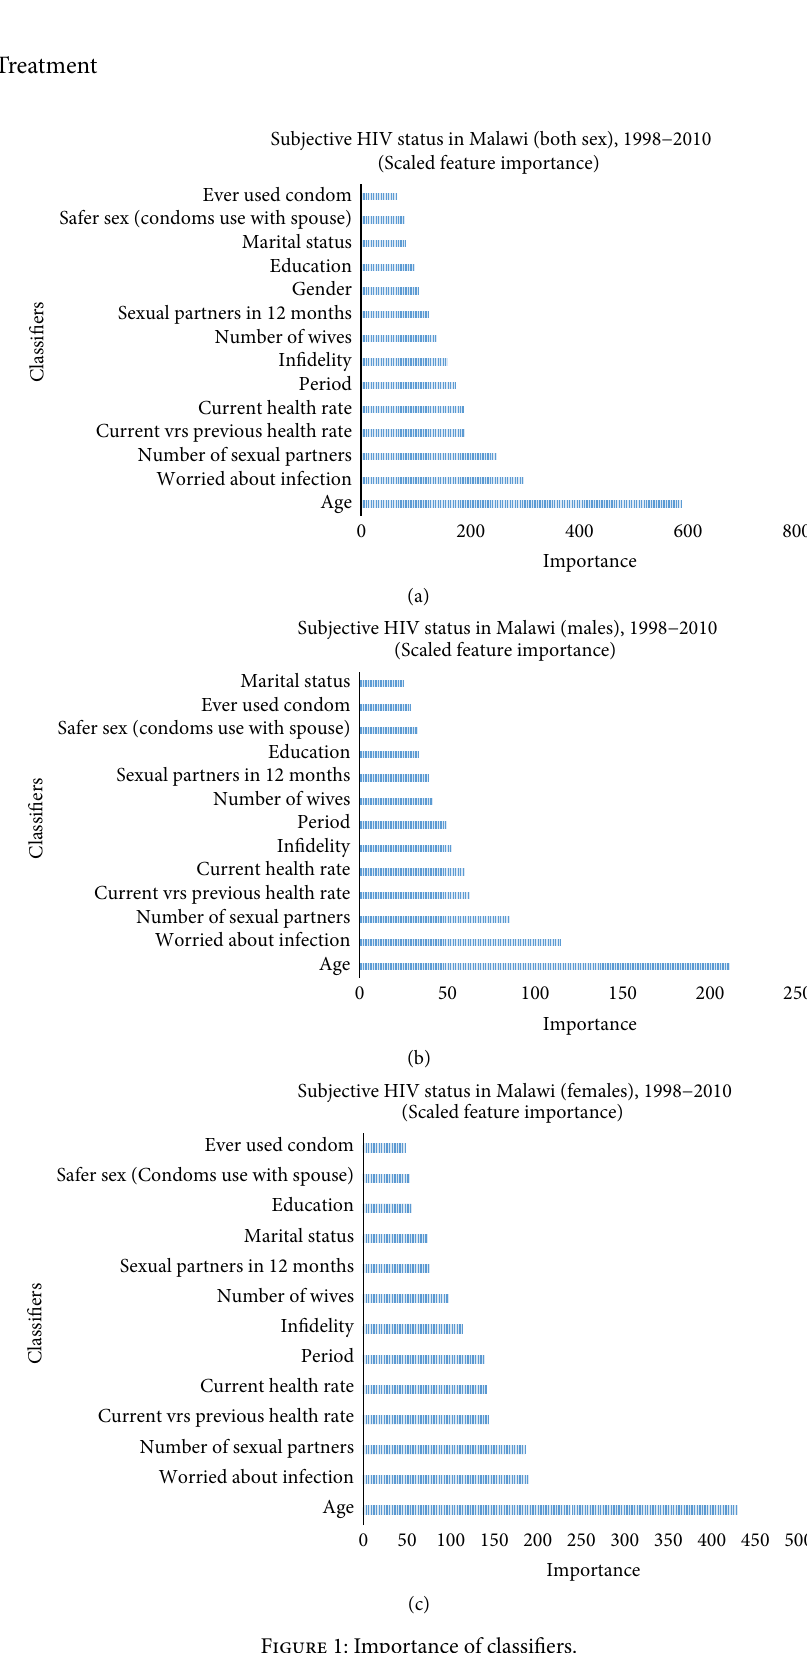
Figure 1: Importance of